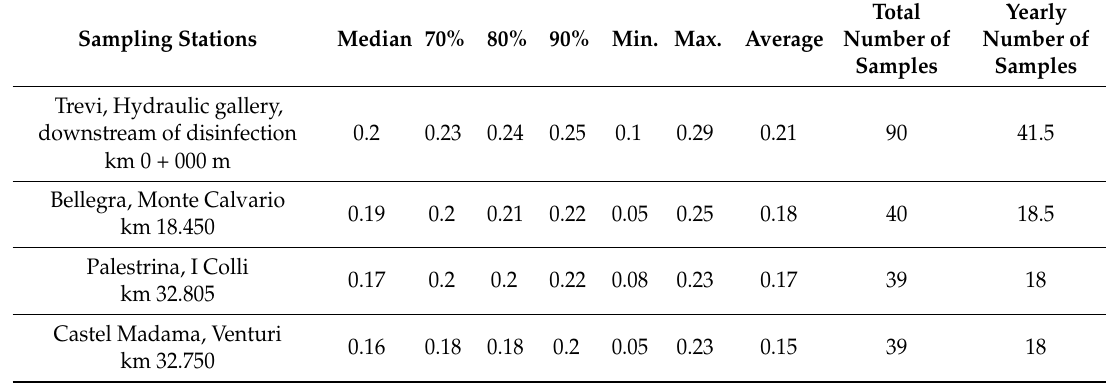
Table 1. Number of samples and statistical parameters related to the observed concentration of free chlorine.